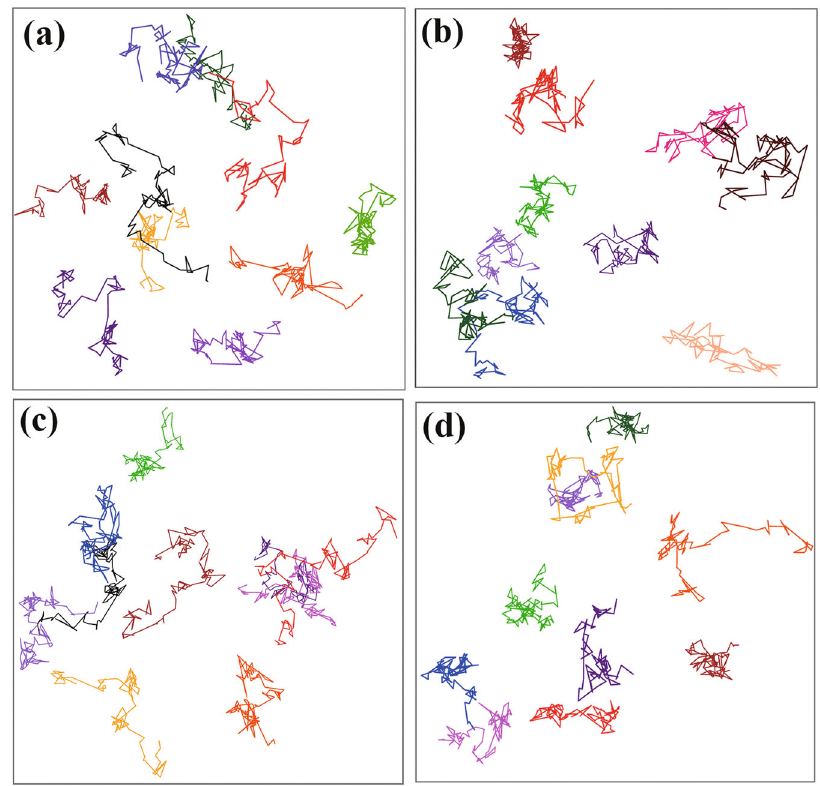
Fig. 14 The diffusion trajectories of O 2 molecules in the unaged and aged PDMS models. a M1, b M4, c M7, and d